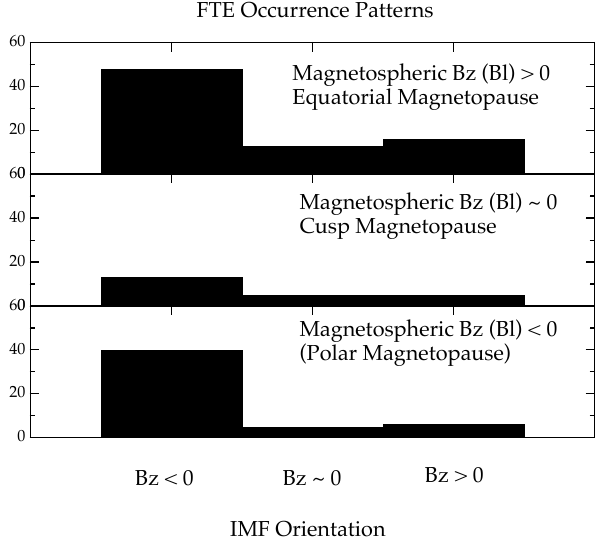
Fig. 11. Results of a statistical survey of event occurrence versus IMF orientations at three locations on the magnetopause. Events on all regions of the magnetopause exhibit a strong tendency to occur for southward IMF orientations.